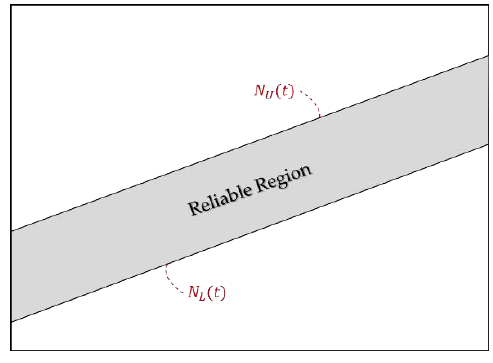
Figure 1. Reliable region in SPRT.